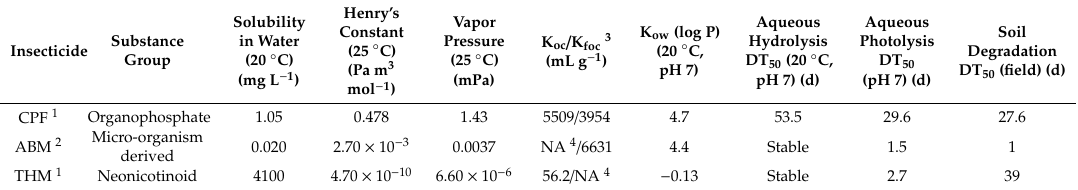
Table 1. Properties of the monitored insecticides obtained from PPDB and